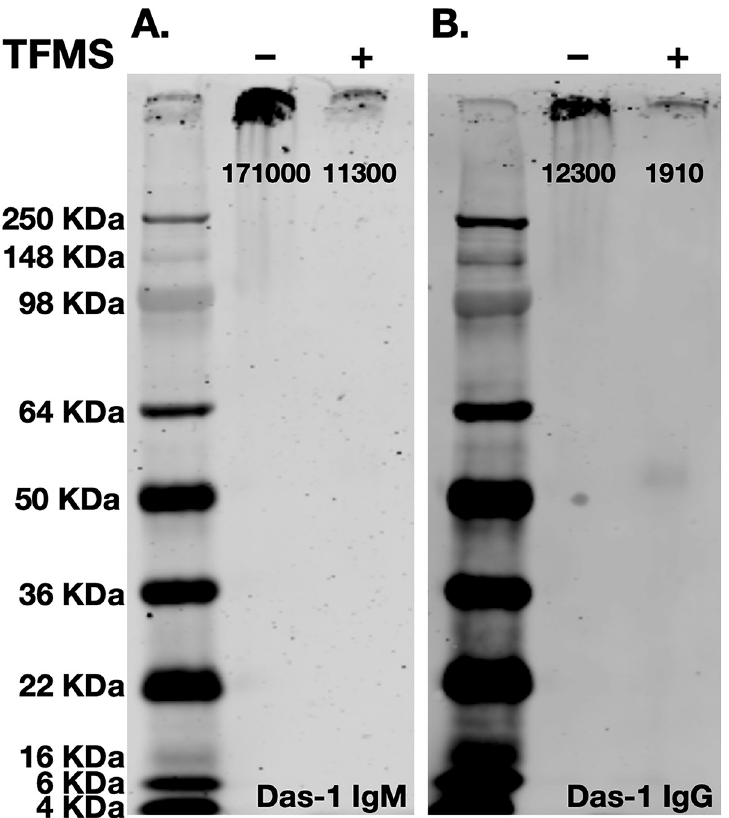
Fig 2. Das-1 IgG and IgM recognize a glycosylation epitope. Chemical deglycosylation of the antigen results in near complete loss of signal as measured by western blot analysis using ( A ) Das-1 IgM and ( B ) Das-1 IgG. Quantification of band intensity is presented below each